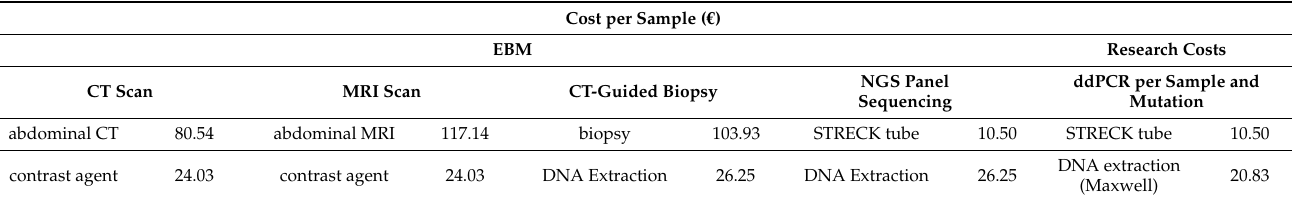
Table 4. Costs of radiological imaging compared to cfDNA